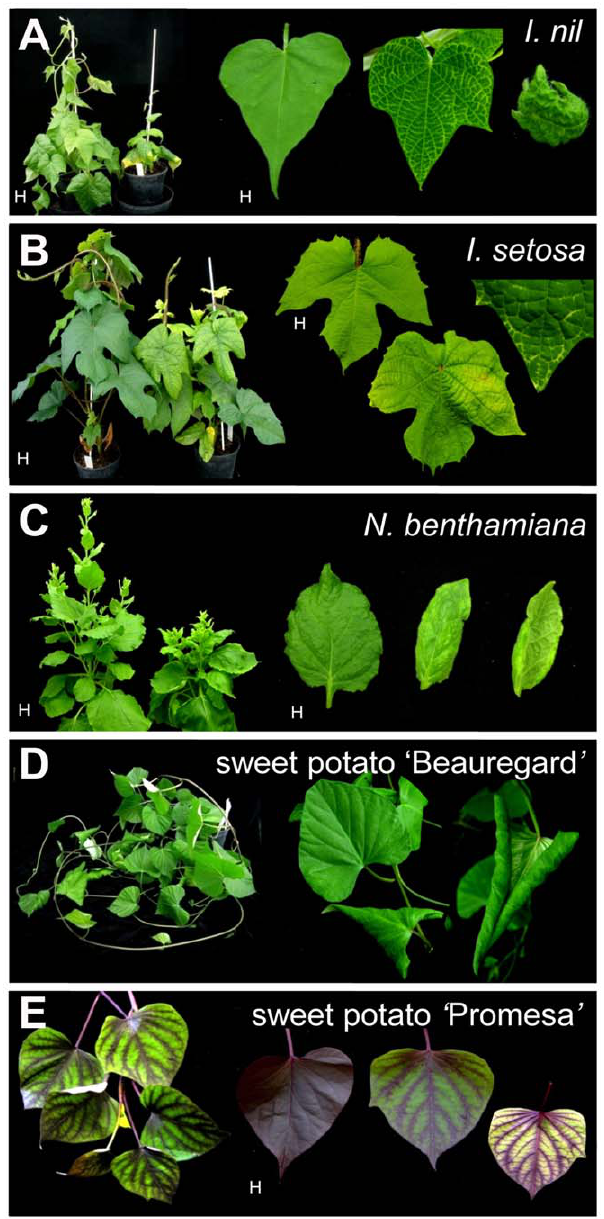
Figure 2. Symptoms observed in plants agroinfected with the clone pDIM-BG30-7-BIN of SPLCLaV. (A) Growth reduction, leaf curling and vein yellowing in I. nil . (B) Growth reduction, yellowing, leaf curling and vein yellowing in I. setosa . (C) Growth reduction, yellowing and leaf curling in N. benthamiana . (D) Leaf curling in sweet potato cv. ‘Beauregard’. (E) Loss of purple pigmentation in sweet potato cv. ‘Promesa’. Symptoms were recorded at 35 days (A–C) and 5 months (D, E) post-inoculation. H, healthy control plants.